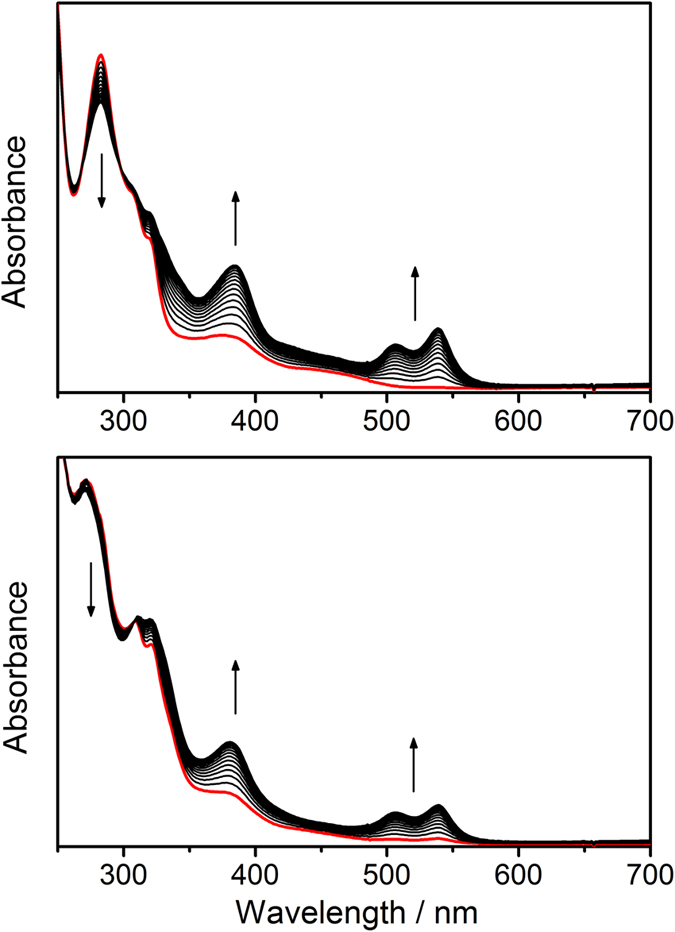
UV–visible absorption spectra for 1a (top) and 2a (bottom) in CH3CN at 298 K during electrochemical reduction at -1.95 V vs Cp2Fe+/0 (10 s traces; initial trace is shown in red).